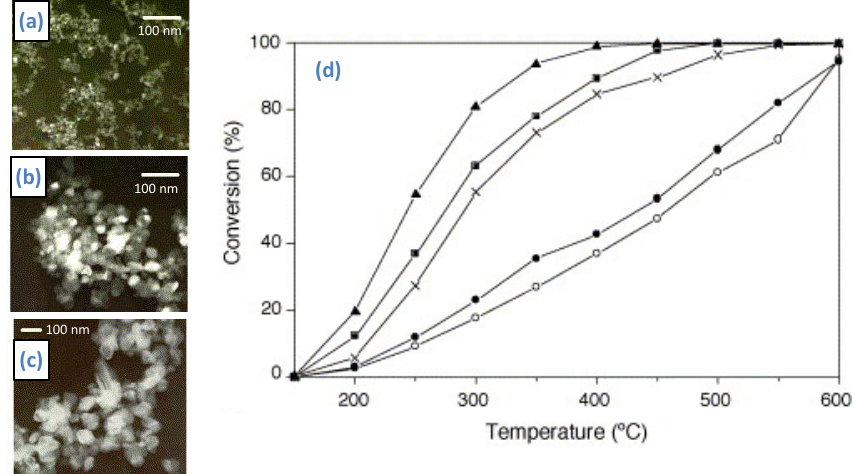
Figure 12. TEM images of: ( a ) 10 wt % vanadia–titania aerogel; ( b ) 5 wt % impregnated vanadia–titania; ( c ) 25 wt % vanadia–titania xerogel; ( d ) Oxidative degradation of 1,2- dichlorobenzene over the V 2 O 5 -TiO 2 catalysts: 2 wt % vanadia–titania aerogel (●), 5 wt % vanadia–titania aerogel ( ■ ), 10 wt % vanadia–titania aerogel ( ▴ ), 5 wt % vanadia–titania xerogel ( ○ ), 5 wt % impregnated vanadia–titania (×). (Adapted with permission from [70]. Copyright Elsevier, 2006).